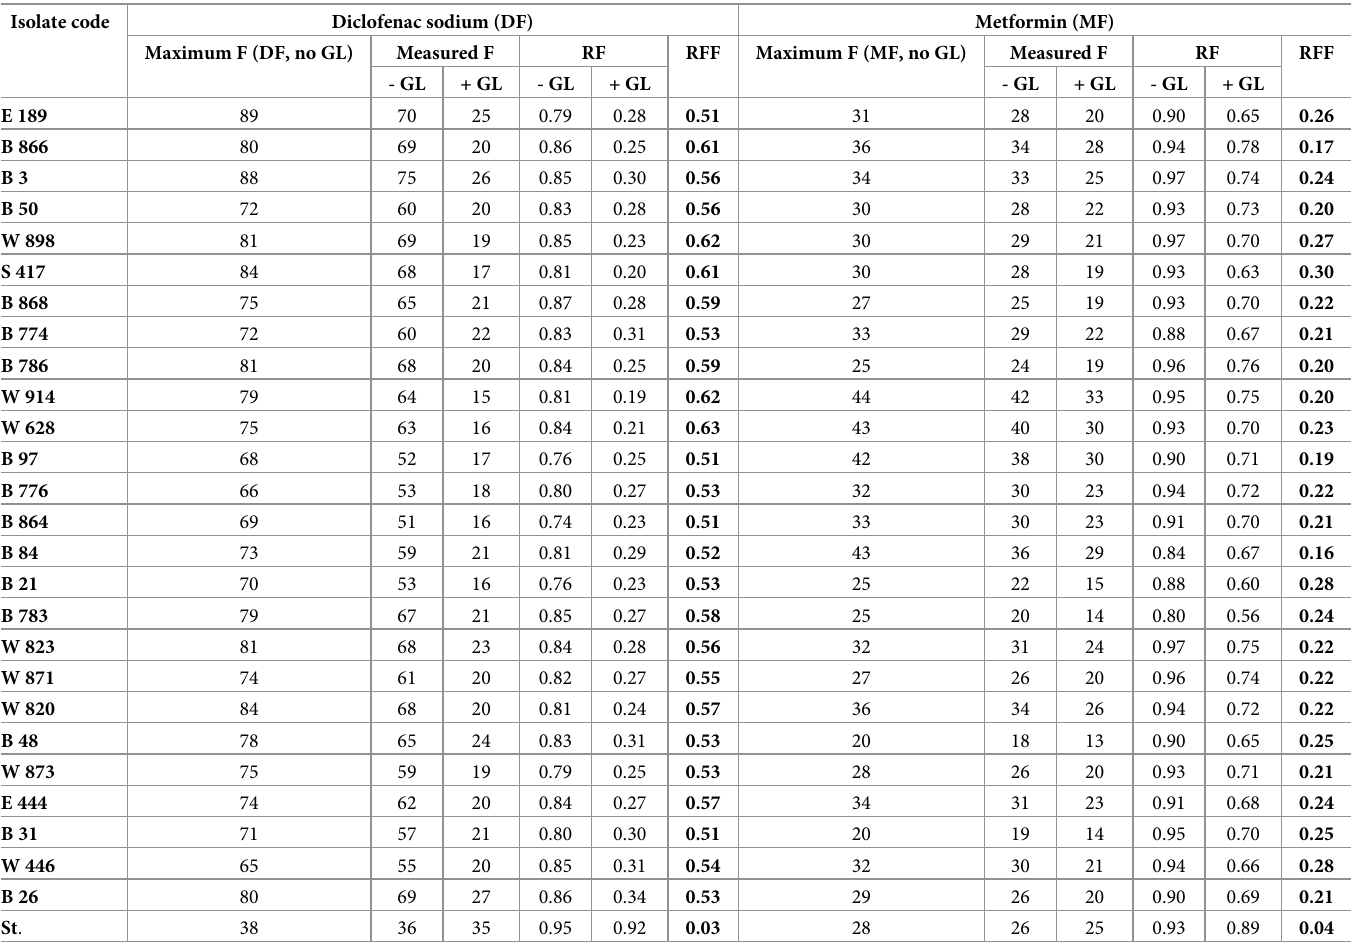
Table 4. Fluorometric efflux assay of isolates in the presence of diclofenac sodium and metformin. Isolate code